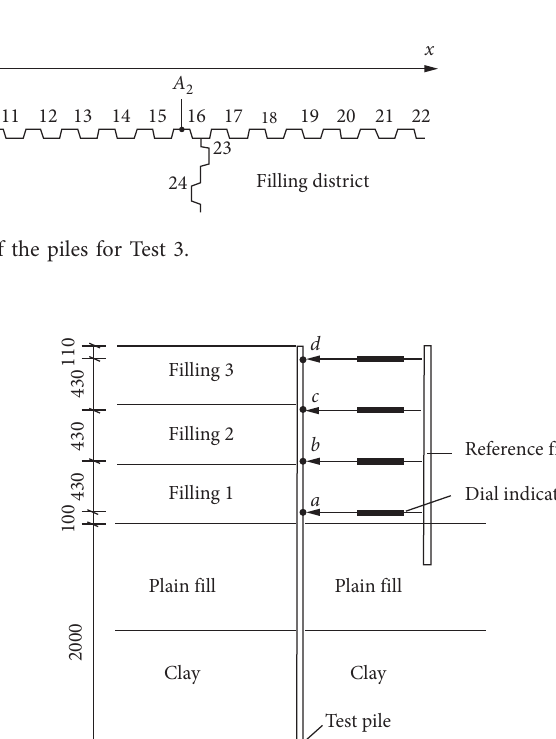
Figure 8: Schematic diagram of the static load testing for Test 2.